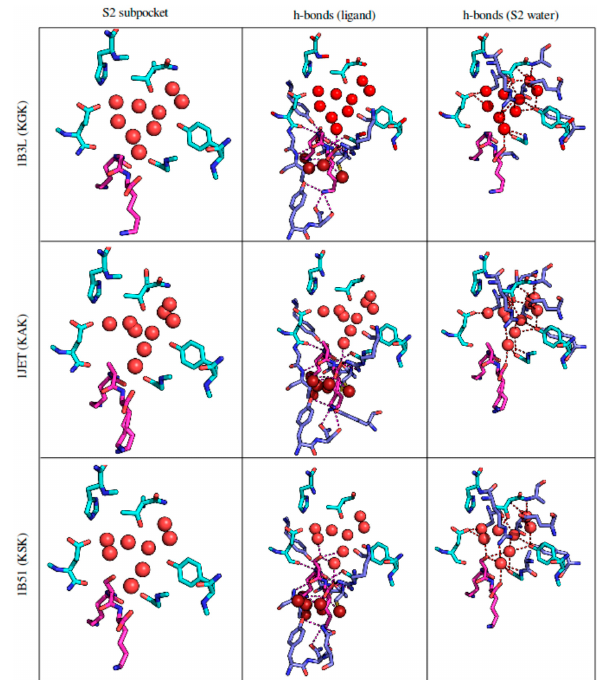
Figure 1. The S2 binding pocket of OppA, taken from the respective crystal structures. Protein residues pointed out by reference [15] are colored in cyan. Protein residues other than these that make hydrogen bonds with either the ligand or S2 subpocket water are depicted in lavender blue. The tripeptide ligand and its hydrogen bonds are colored in magenta. Water molecules are depicted as spheres: Water in the S2 subpocket (pointed out by reference [15]) and its hydrogen bonds are colored bright red; water with bonds to the ligand is colored dark red. Hydrogen bonds were estimated by PyMol’s polar contacts function, which is based on DSSP. For details on individual water molecules see Figure S1 in the Supplementary Materials. The total potentially available binding pocket volume in OppA has been estimated at an enormous ~1000 Å 3 [17]. Nevertheless, the binding mode geometry of all ligands in the published KXK series is virtually identical, with the backbone occupying a single specific pose in extended conformation, and the side chains being solvated in active site water. In spite of this common binding mode, the observed binding affinities vary over a relatively wide range. As direct interactions of either backbone or side chains with the protein cannot be the cause of observed differences in binding affinity for the KXK series, it is suspected that the different ligands are indirectly distinguished by their slightly different disruption of the conserved binding pocket solvent network. In this way, otherwise chemically highly similar ligands (such as KEK and KDK [15]) displace a different amount of water molecules from their optimized, orderly position. Just a small increase in ligand size causes a disturbance of the precarious balance between enthalpy of binding and entropy of water release.